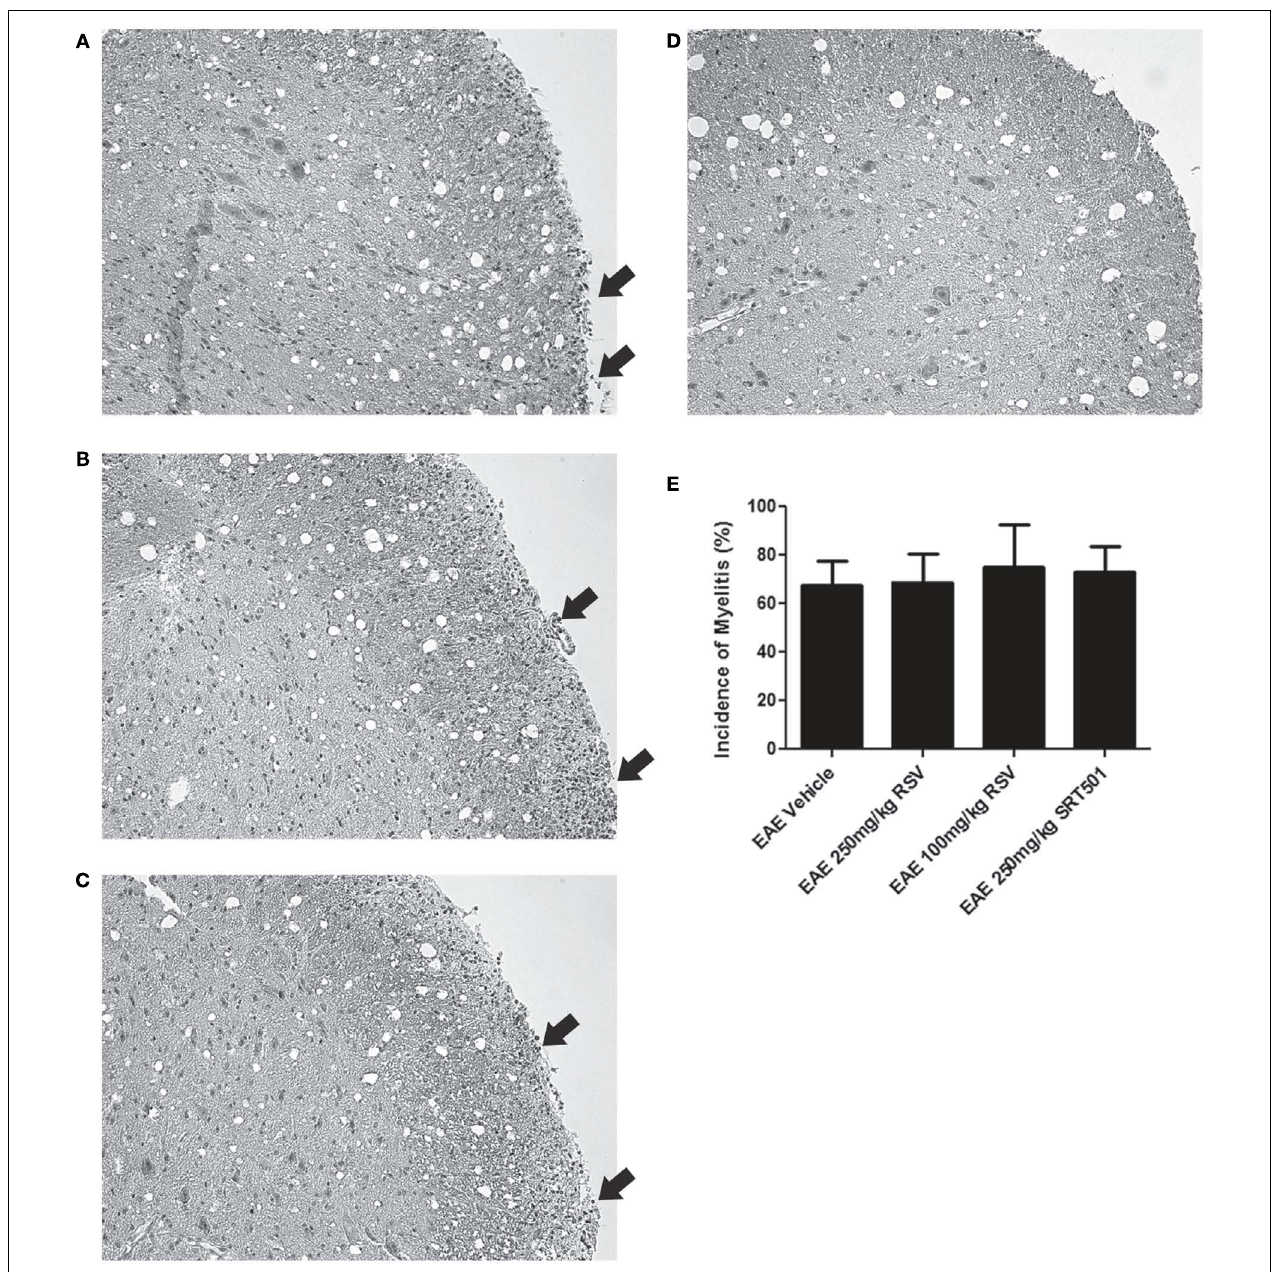
treated with 250mg/kg RSV (B) and 250mg/kg SRT501 (C) . (D) Spinal cord from a control, non-EAE mouse demonstrates the normal cellularity without inflammatory cell infiltration. (E) The percentage of spinal cord sections containing inflammatory cell infiltrates did not differ between PBS-, RSV-, or SRT501-treated EAE mice. Photos shown at original magnification × 20 (A–D) .